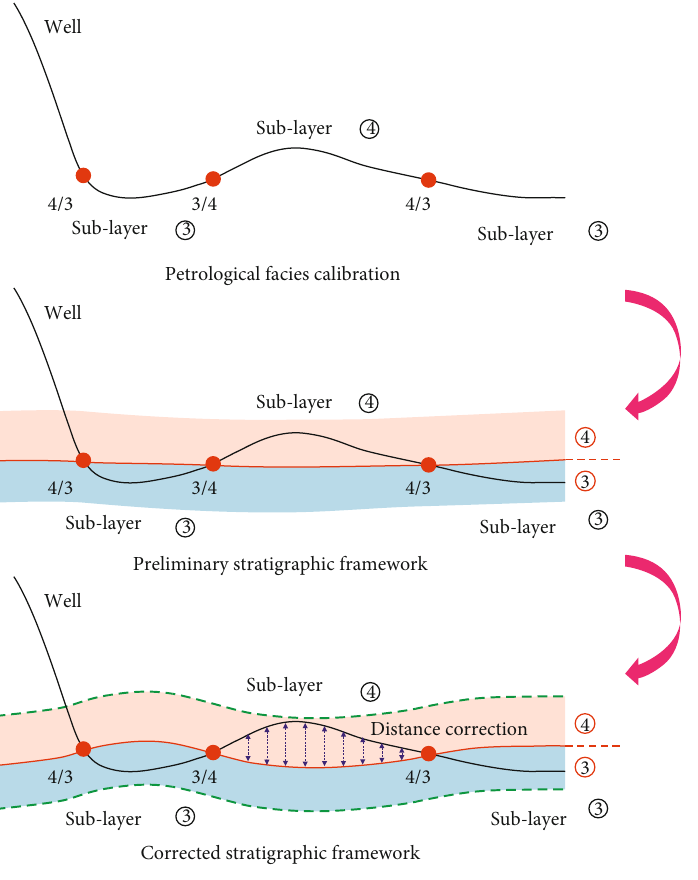
Figure 6: Correction of the distance between the drilling trajectory and the interface of sublayers in the shale formation.